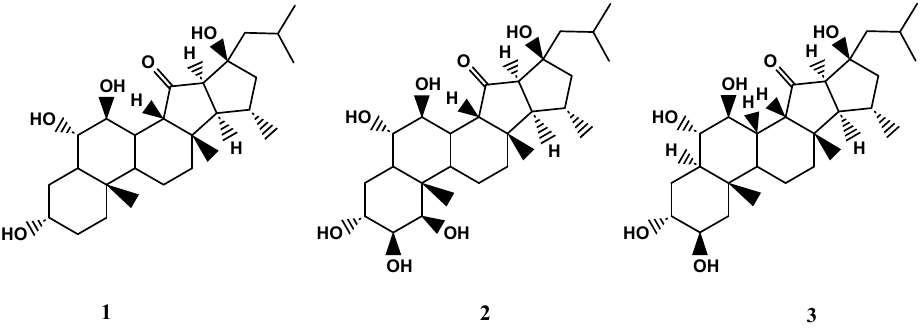
Figure 4. The chemical structures of xestobergsteroles A-C ( 1 - 3 ).